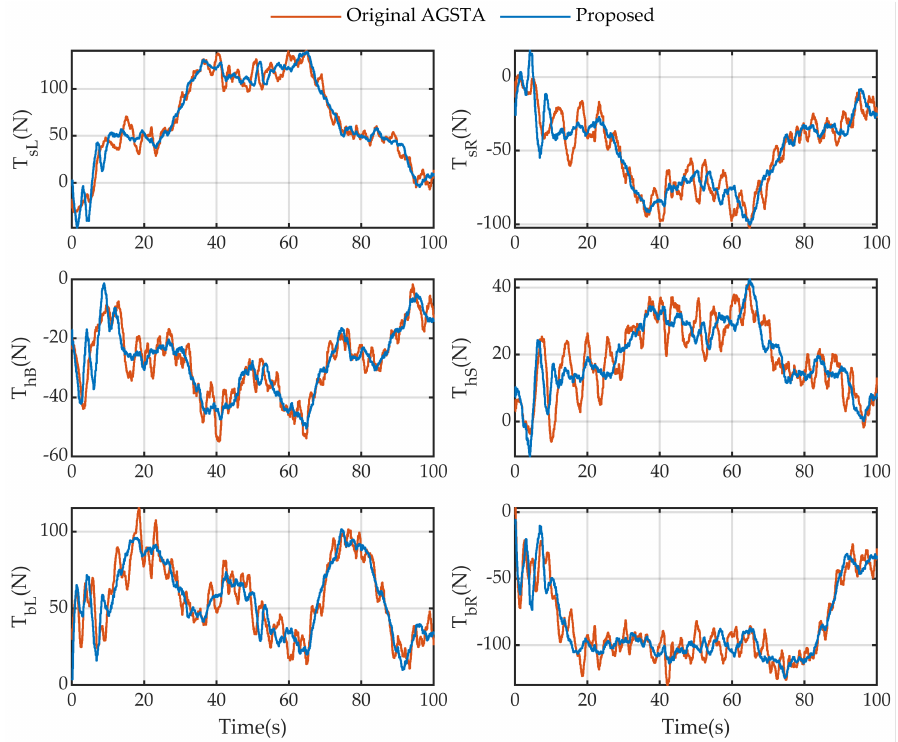
Figure 7. Thrust force for each thruster during station-keeping